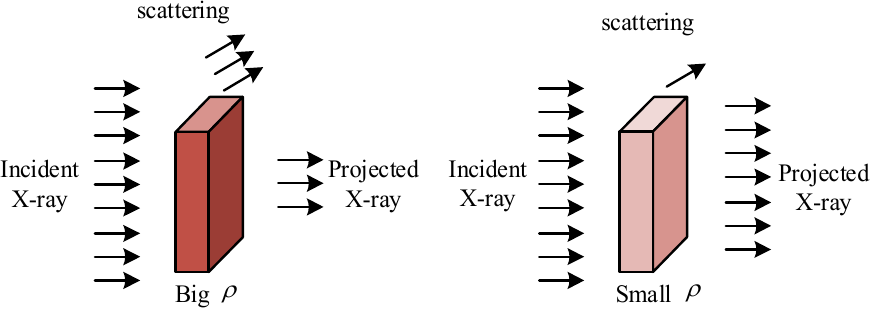
Figure 5. Influence of density on X-ray fading [38].